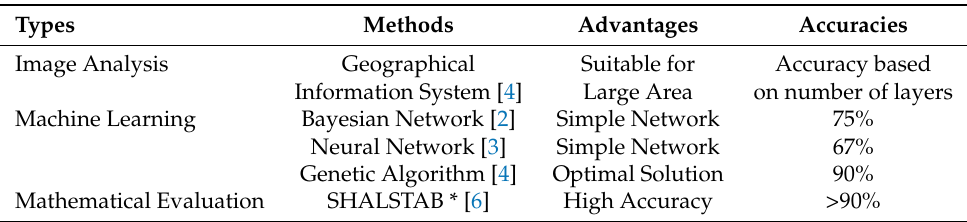
Table 1. Comparison of Landslide Detection/Prediction